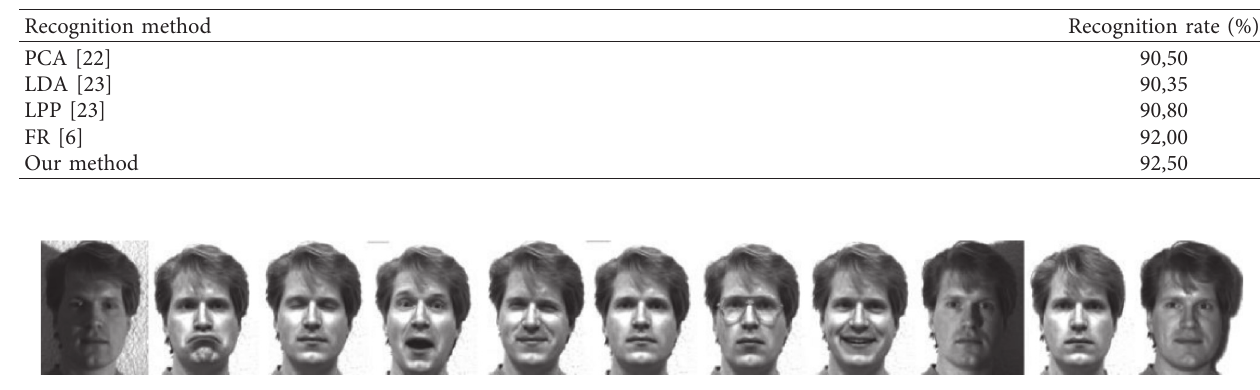
Table 3: Recognition rates (%) of the proposed method and different approaches on the ORL